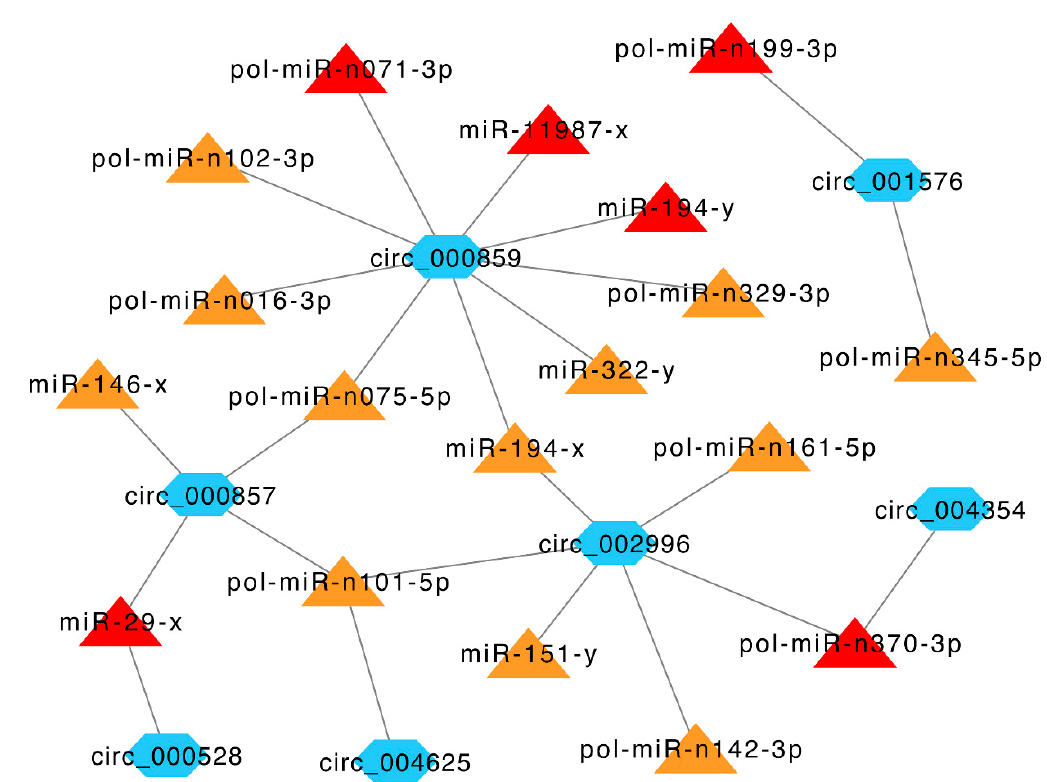
Figure 6. Immune-related networks formed by interactive DEcirs and DETmiRs. The blue hexagon nodes indicate DEcirs. The triangle nodes indicate DETmiRs, of which the key miRNAs induced by V. anguillarum identified in a previous study [23] are in red, and the miRNAs identified in this study are in orange. The interactive relationships between DEcirs and DETmiRs are indicated by connecting lines.